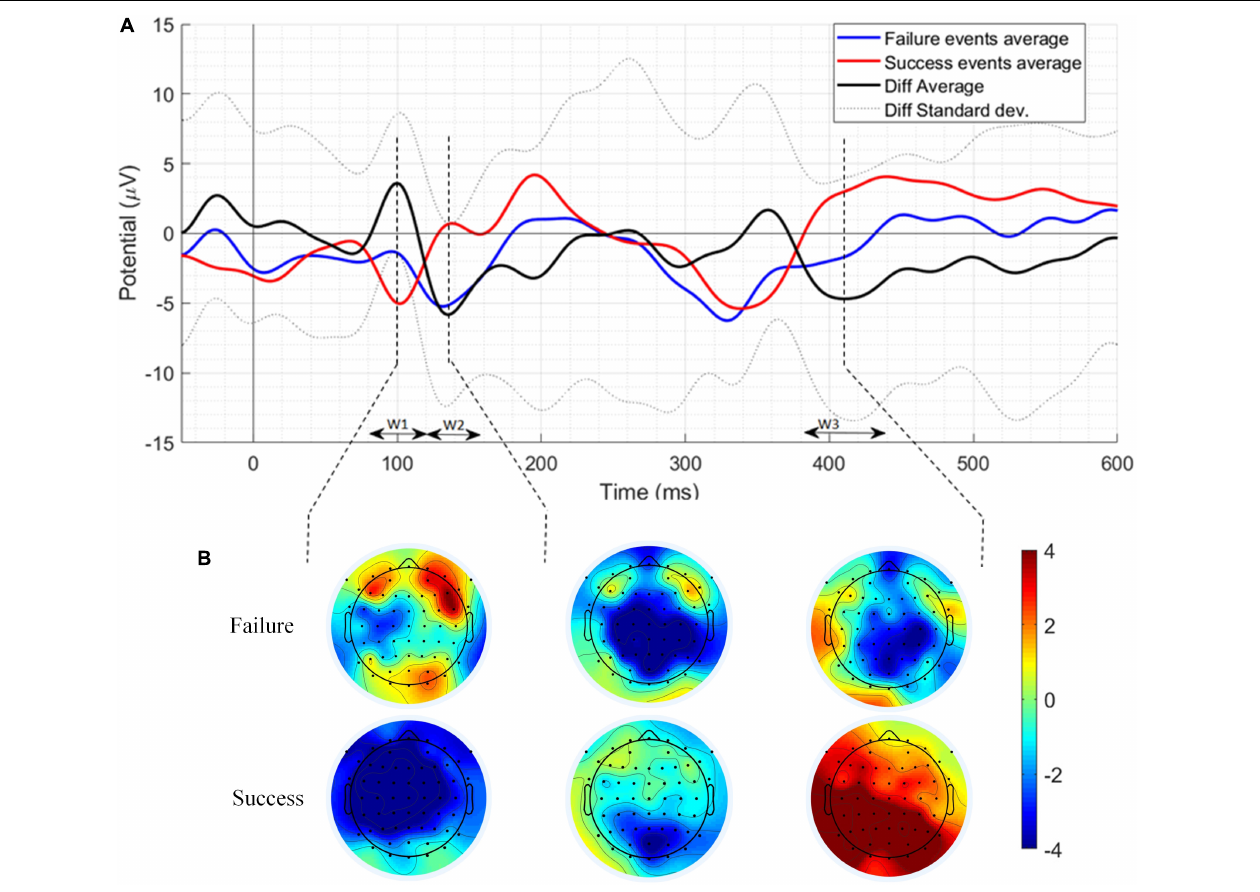
FIGURE 2 | (A) The grand average ERPs of the failure events, success events, difference ERP along with its standard deviation at Cz electrode location. W1, W2, and W3 represent three times windows selected for analysis based on the most prominent peaks. (B) Scalp distribution maps of the most prominent peaks.